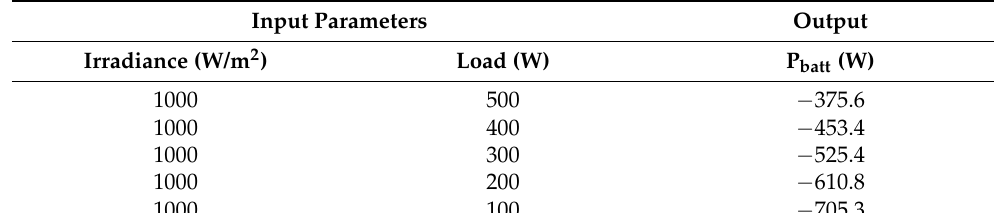
Figure 6. ANFIS network structure for P batt.